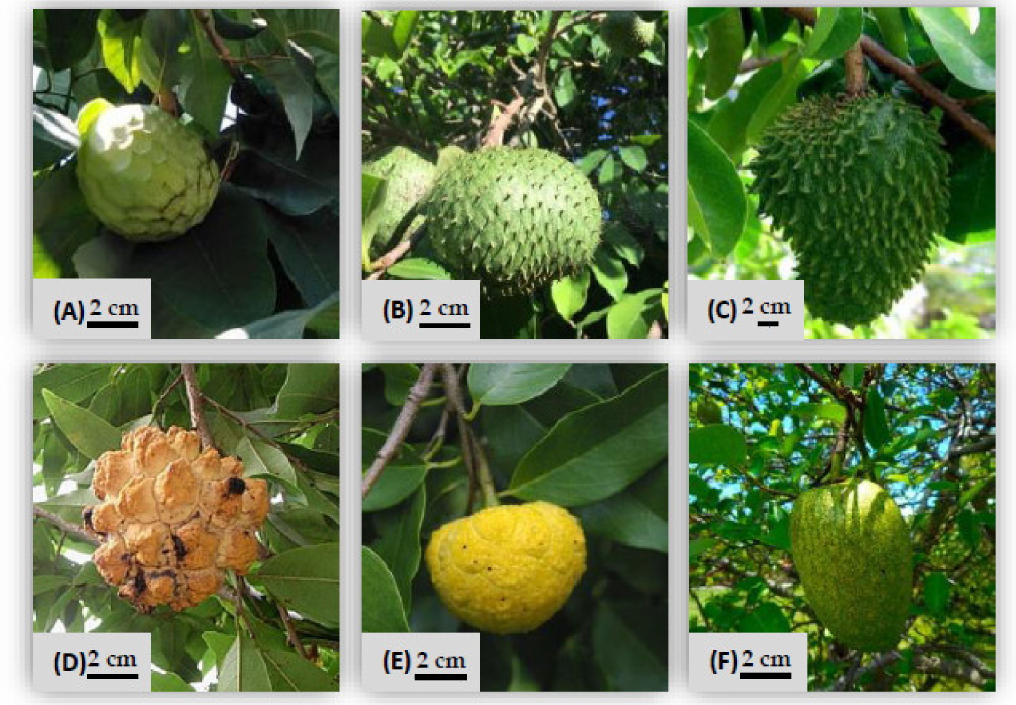
Figure 1. Sample images of the different Annona species used in this study: ( A ) A. cherimola (cherimoya); ( B ) A. montana (soursoup); ( C ) A. muricata (guanabana or soursop); ( D ) A. neosalicifolia ; ( E ) A. emarginata ; ( F ) A. glabra (pond